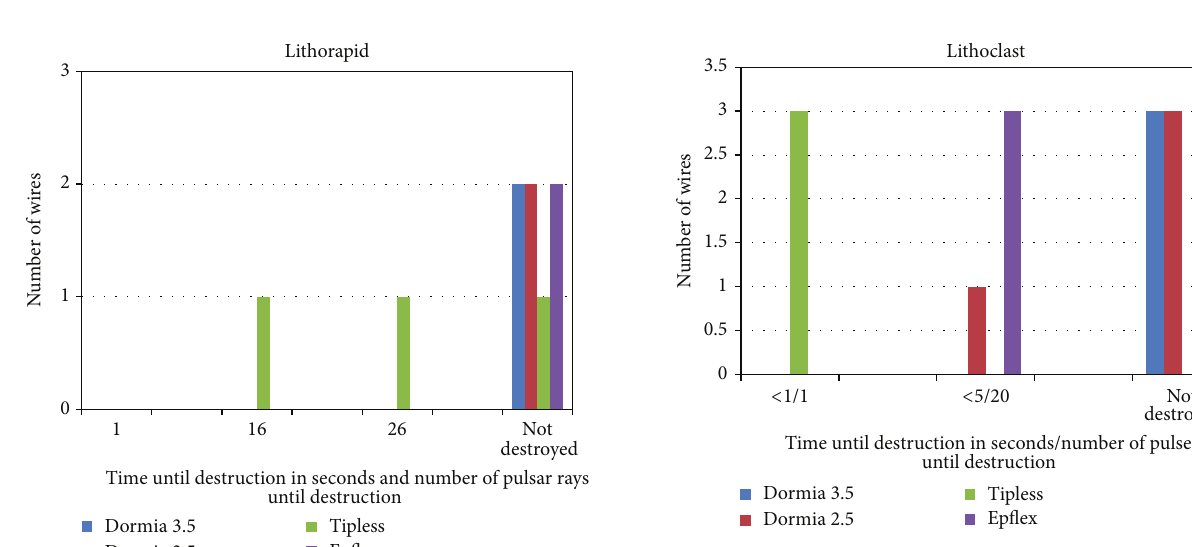
Figure6:Pneumatic-ballisticdevice(Lithoclast)forthedestruction of all 1.8 F tipless baskets, 3 of four 2.5 F tipless baskets, and one of four 2.5 F Dormia baskets. For the 1.8F tipless baskets, the device just needed less than one second/one pulse. For the bigger wires, the device needed fewer than 5sec/20 pulses.